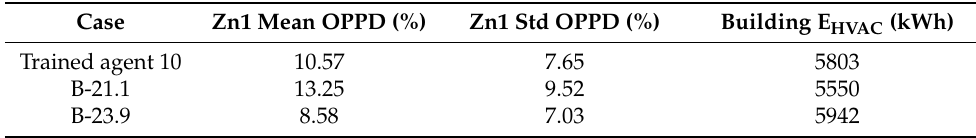
Table 6. The results of single-zone testing in the testing building model.